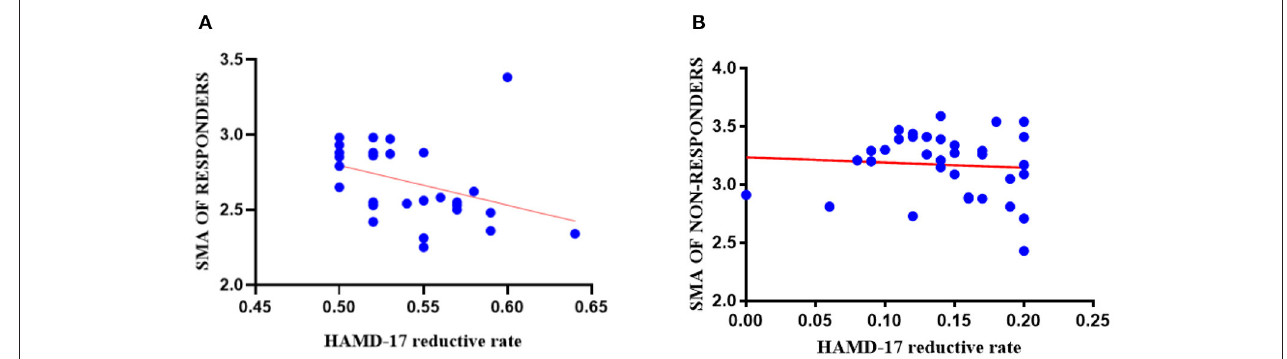
FIGURE 4 | The results of correlation analyses in the responder group and the non-responder group. (A) The cortical thickness of right SMA (0 weeks) in the responder group had a negative correlation with 2-week HAMD-17 reduction ( r = − 0.373, p = 0.044); (B) The cortical thickness of right SMA (0 weeks) had no statistically significant correlation between the non-responder group and 2-week HAMD-17 reduction ( r = − 0.072, p =